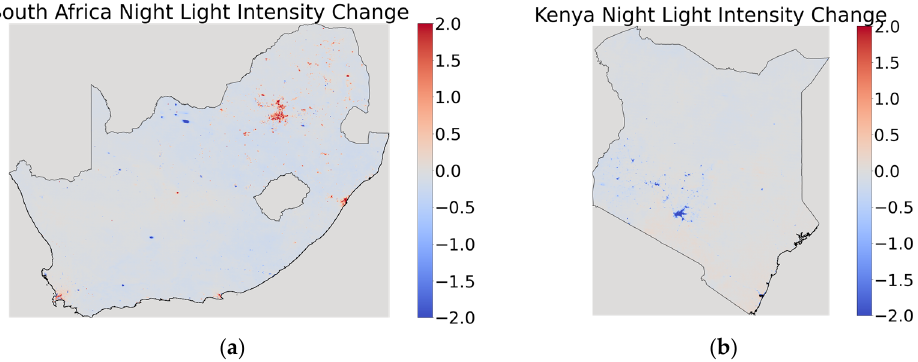
Figure A1. ( a ) Change in night light intensity in South Africa; ( b ) change in night light intensity in Kenya.